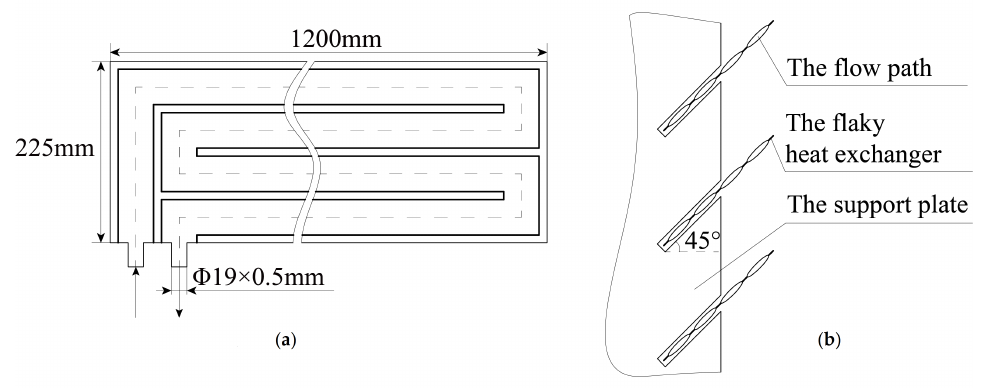
Figure 3. The flaky heat exchanger: ( a ) is a diagram of the pipeline in the flaky heat exchanger with 4 processes; ( b ) is the installation of the flaky heat